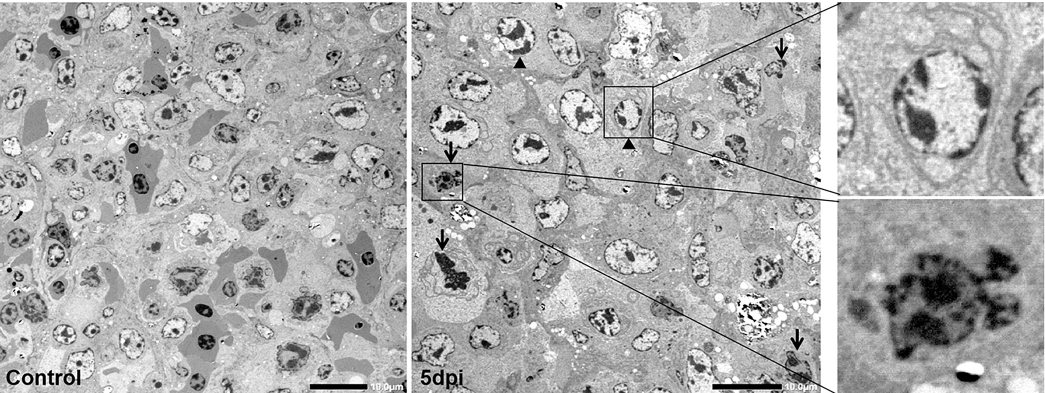
Figure 6. Ultrahistopathological changes in spleen induced by GNAstV infection. Arrow: Condensed chromatin and apoptotic cells among lymphocytes. Triangle: swollen mitochondria and impaired plasma membrane integrity in reticular cells. Scale bar: 10 µ